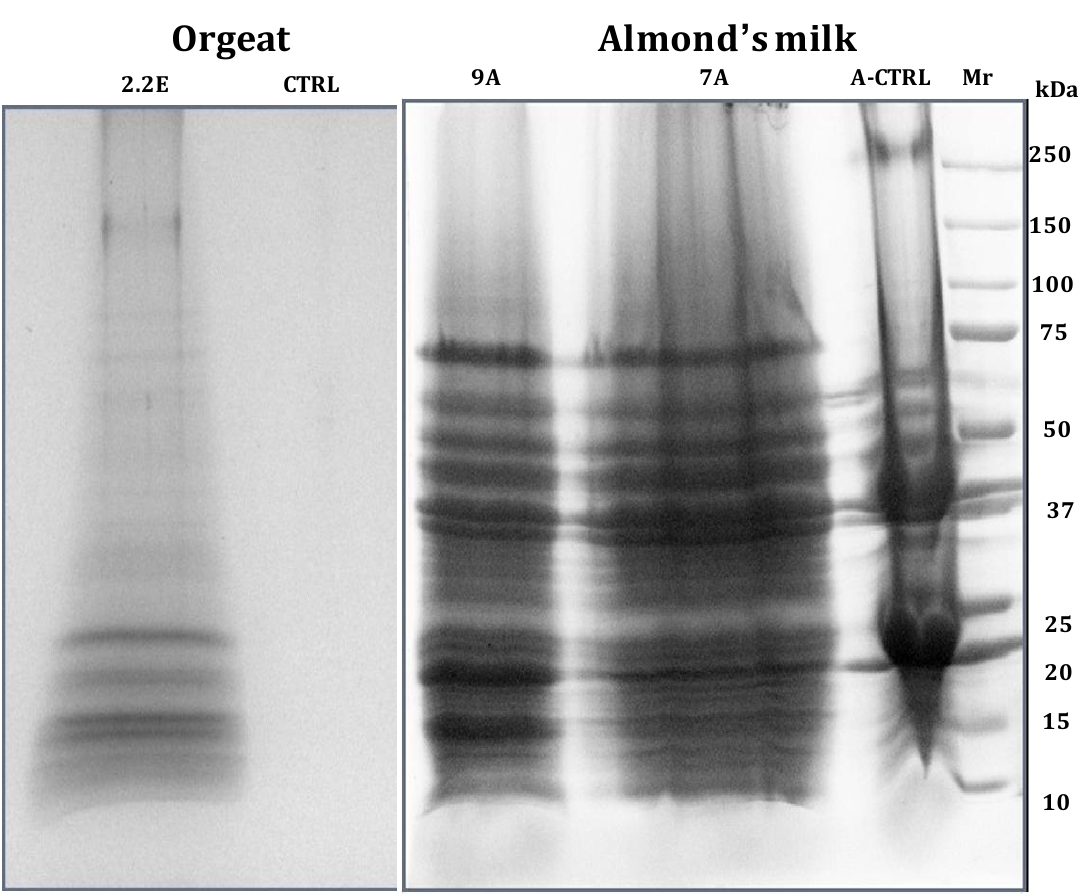
Figure 3. SDS-PAGE profiles of orgeat syrup (two tracks to the left) and of almond’s milk (right panel). Orgeat: CTRL = 100 μL of control orgeat solution before CPLL treatment. 2.2 E = 50 μL 2% SDS eluate of orgeat solution treated with a home-made-CPLL library at pH = 2.2. Almond’s milk: control (A-CTRL) and eluates from a 1:1 mixed library of PM and home-made-CPLLs at pH 7.2 (7A) and pH 9.3 (9A) values (modified from Fasoli et al.